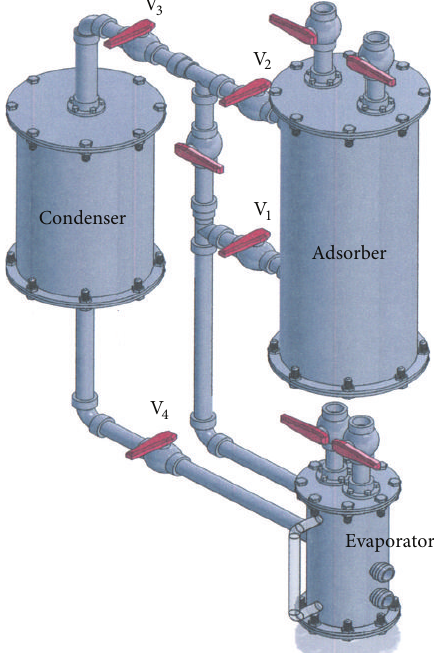
Figure 2: Photograph of adsorption refrigeration system.